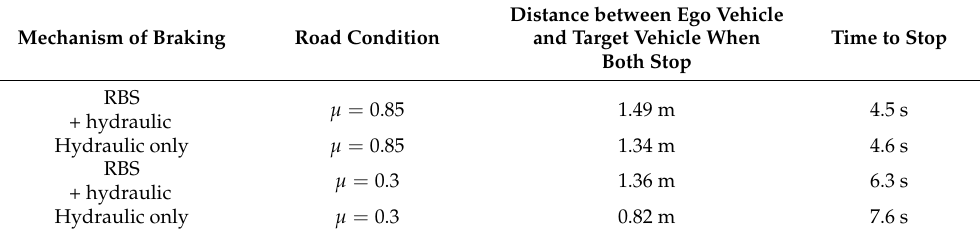
Table 3. AEBS simulation tests results.